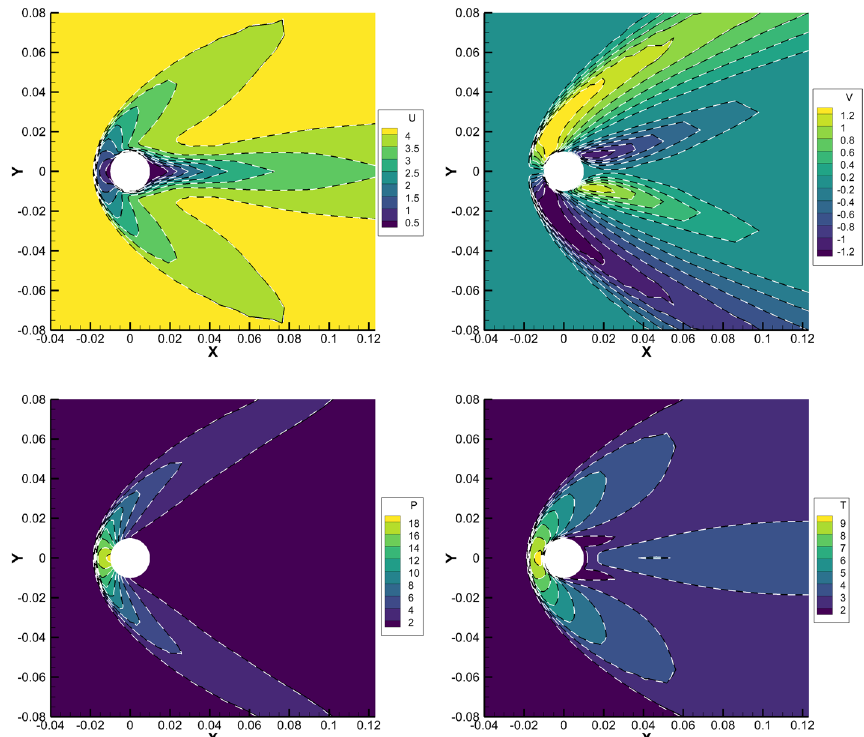
Fig. 15 Comparison of u -velocity, v -velocity, pressure and temperature contours for flow around a circular cylinder at Ma 5 and Kn 0.01 (ADUGKS: colored background with black solid line; DUGKS: white dashed = =